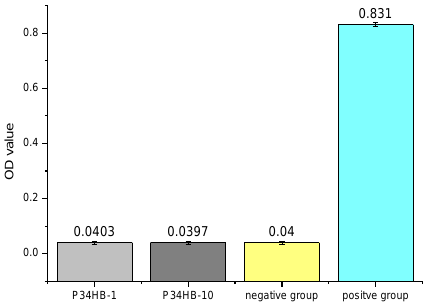
Figure 8. OD values of hemolysis rates for P34HB-1 and P34HB-10.